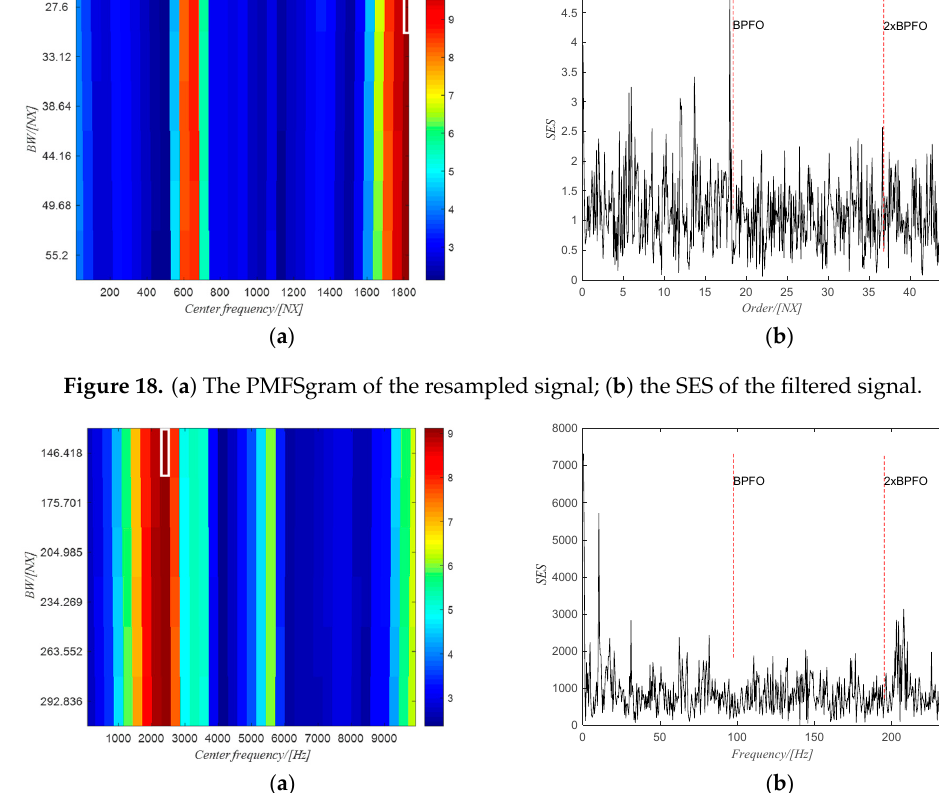
Figure 19. ( a ) PMFSgram of the raw signal, case 1; ( b ) SES of the filtered signal.